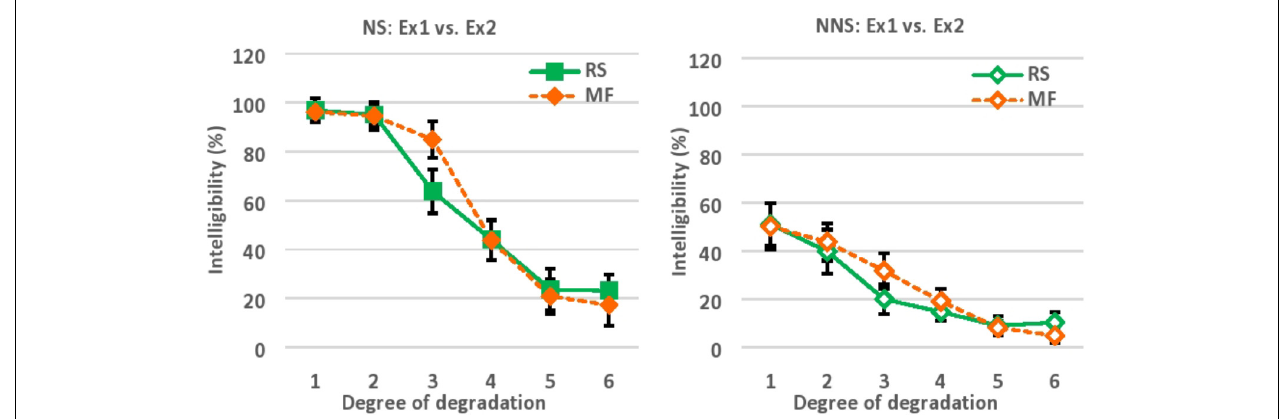
FIGURE 5 | The results of Experiment 1 and 2 for NS is plotted together (left) , and the results of Experiment 1 and 2 for NNS is plotted together (right) for comparison. NS, Native speakers of English; NNS, Non-native speakers of English (native Japanese speakers who speak English as a second language), Ex1, Experiment 1; Ex2, Experiment 2; RS, Locally time-reversed speech (Experiment 1); MF, Modulation-filtered speech (Experiment 2); Degree of degradation, 1 (10 ms, 32 Hz), 2 (30 ms, 16 Hz), 3 (50 ms, 8 Hz), 4 (70 ms, 4 Hz), 5 (90 ms, 2 Hz), 6 (110 ms, 1